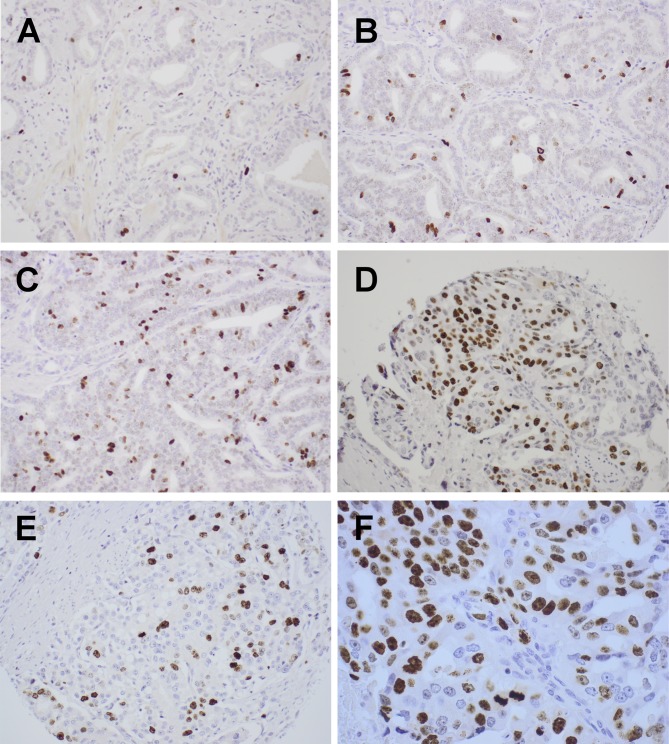
Representative immunohistochemical staining for Ki-67.(A) Gleason grade group 1 (3+3) with Ki-67 <1–2.5%; (B) Gleason grade group 3 (4+3) with Ki-67 <1–2.5%; (C) Gleason grade group 3 (4+3) with Ki-67 2.6–4%; (D) Gleason grade group 4 (4+4) with Ki-67 ≥ 5; (E) Gleason grade group 5 (4–5) with Ki-67 2.6–4; (F) Picture showing the different Ki-67 expression of nuclear staining, varying from negative to strong.